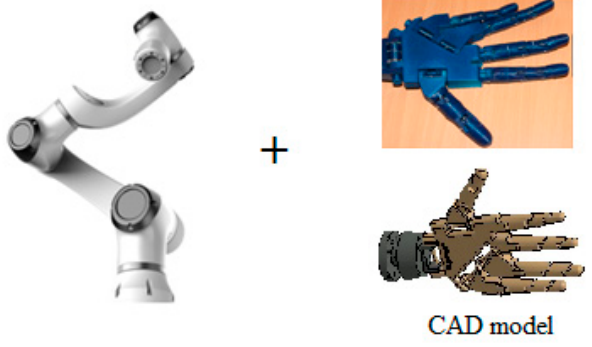
Figure 9. Recommendation for coupling a human arm robot with an anthropomorphic five-finger grip.